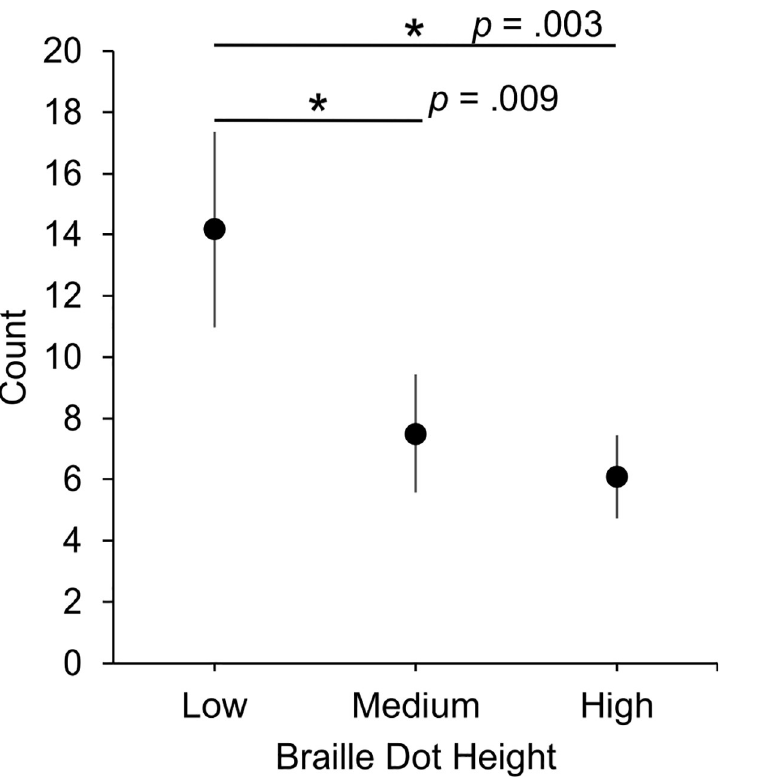
Fig 4. Average number of repeat regressions (with SEMs) at three braille dot heights.